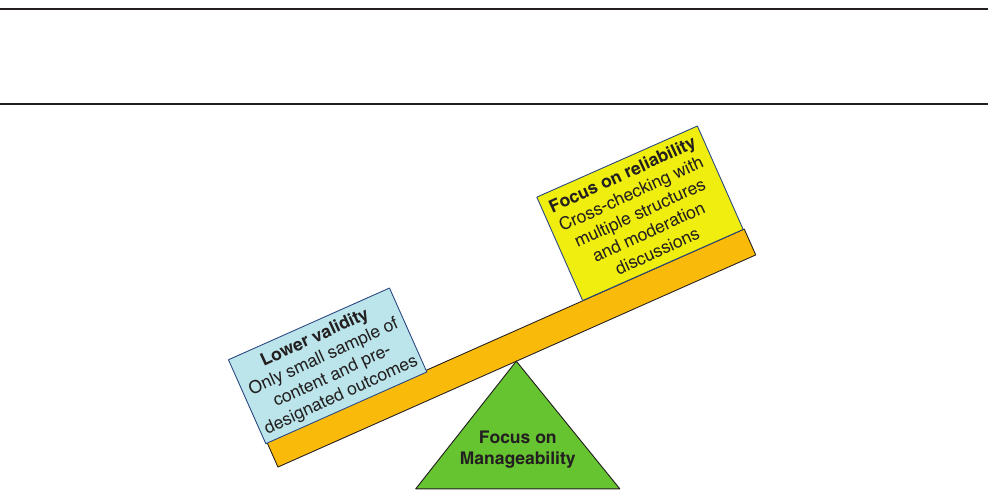
Figure 1: Phase 1 Summative teacher assessment seesaw: Focus on reliability